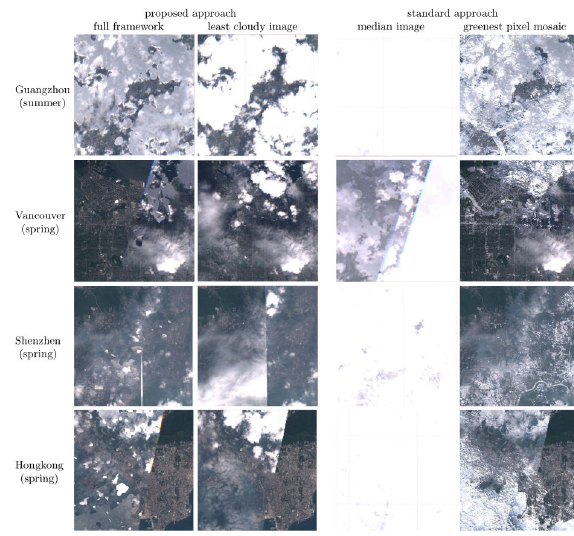
Figure 12. Cloud-free image aggregation examples for areas strongly affected by clouds, but with an extra month added to the seasonal (three-month) aggregation